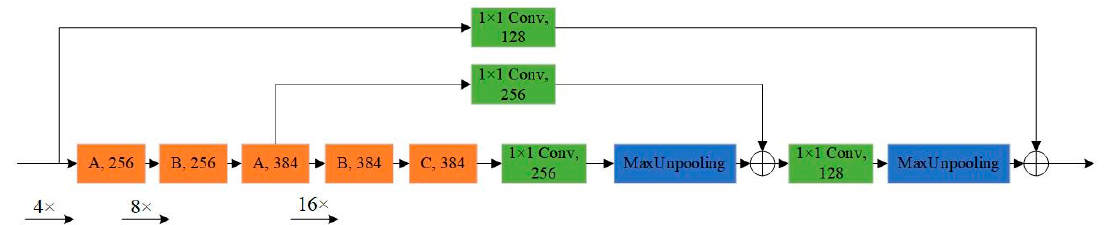
Figure 5. An illustration of the encoder-decoder module. According to different requirements, the MRF block has three different structures (A, B, and C). Note that the numbers in each block represent the number of filters. When the down- sampling factor reaches 16, the resolution of the feature map is not reduced.